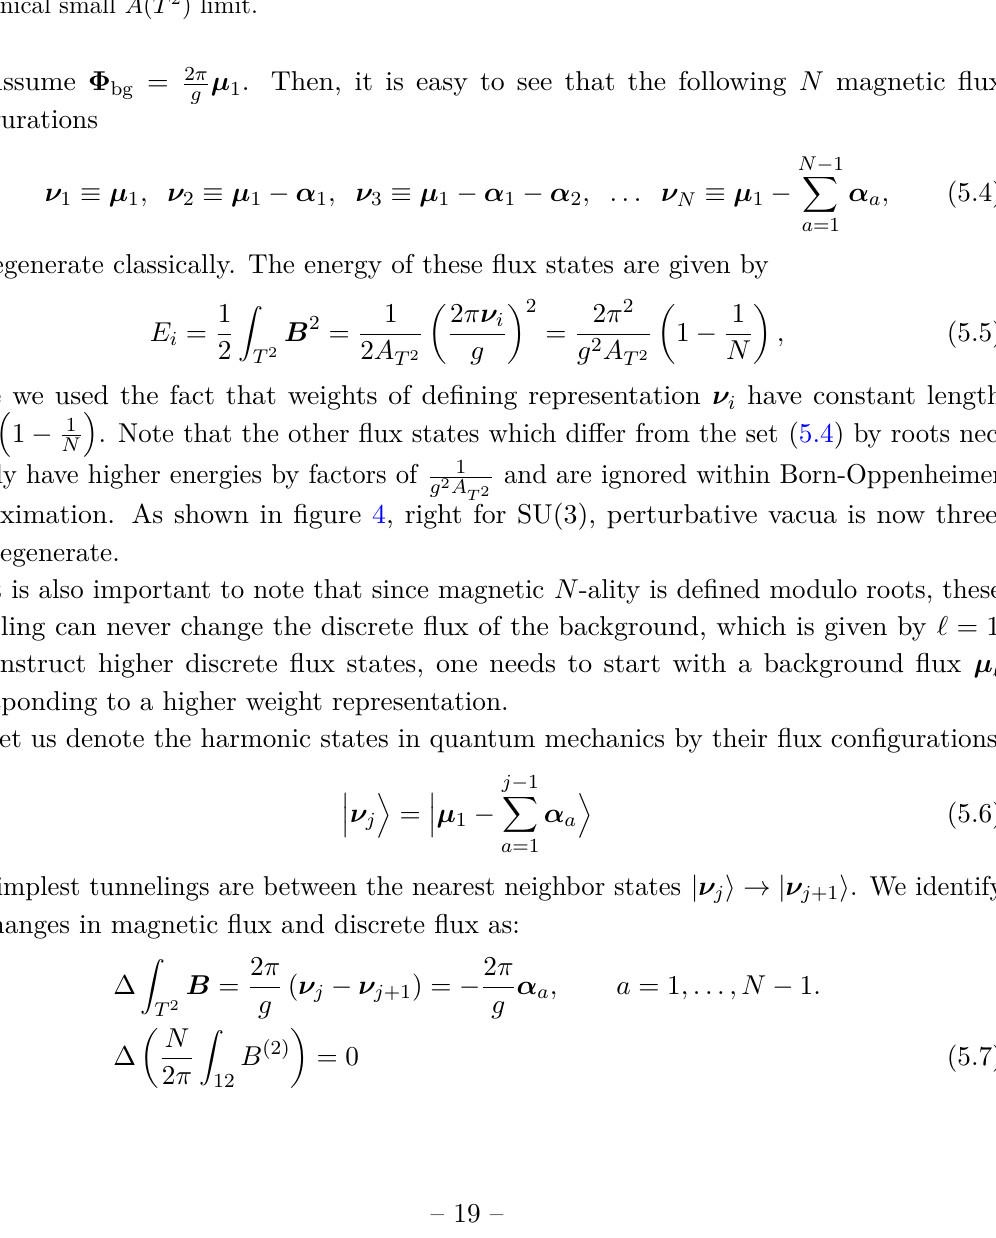
Figure 4 . Compactification of SU(3) Polyakov model to QM for Φ bg = 0 and Φ bg = µ 1 background magnetic flux. For Φ = 0 , the vacuum is unique perturbatively and flux states have higher energy. bg For Φ = µ , the vacua is three-fold degenerate perturbatively, and instanton persist in the quantum bg 1 mechanical small A ( T 2 )